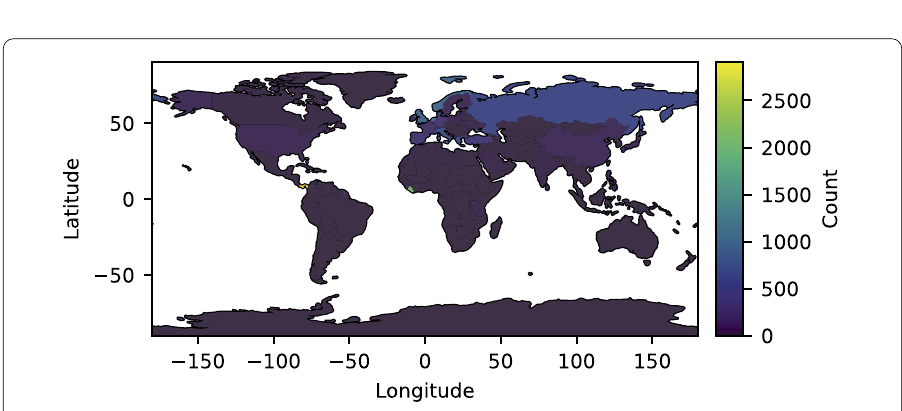
Figure A2 Number of ships registered to each country. If multiple registrations for a single ship were observed, we use the most recent